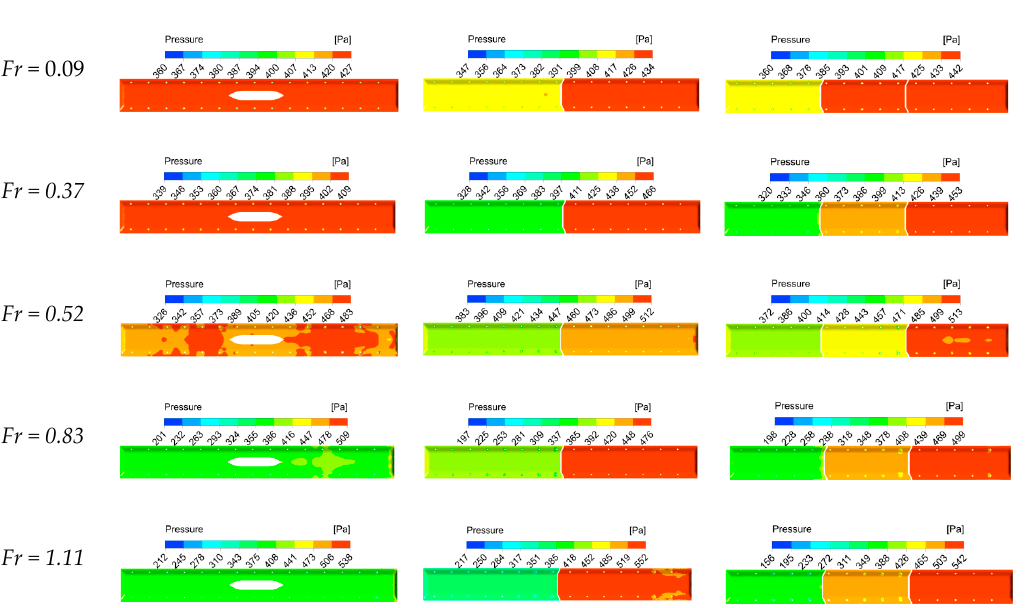
Figure 21. Pressure distribution of top panel of the hover chamber (model with single, two and three cushion from left to right).